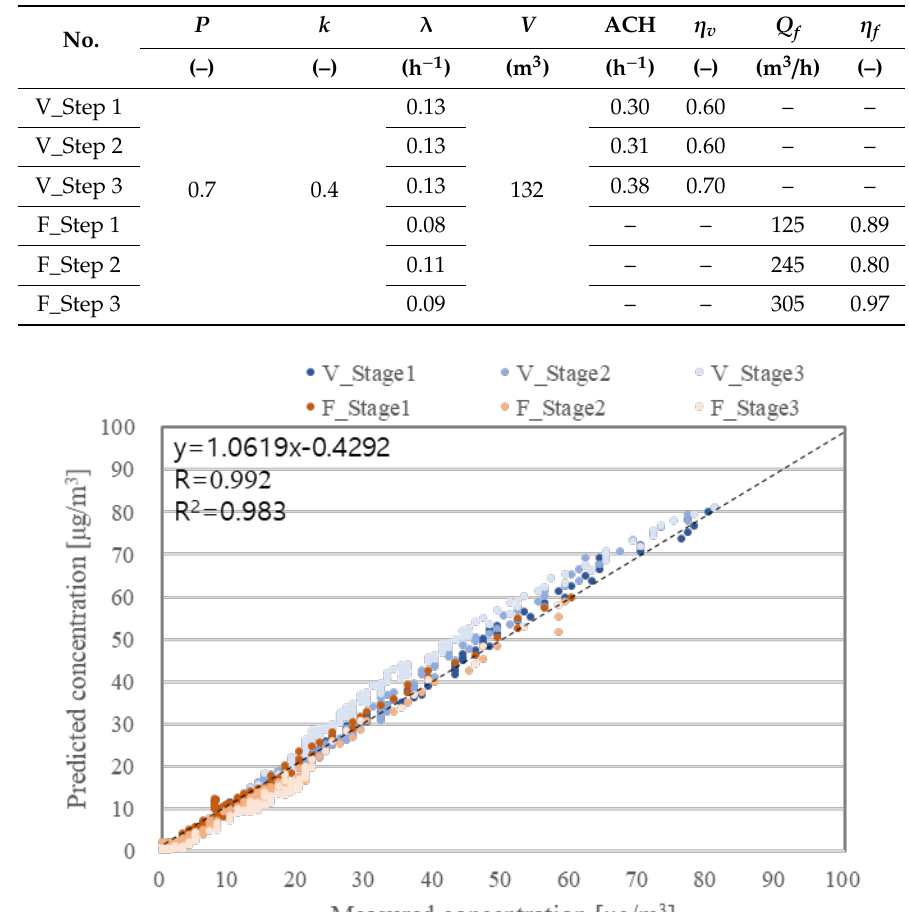
Table 5. Input values used for parameter validation.